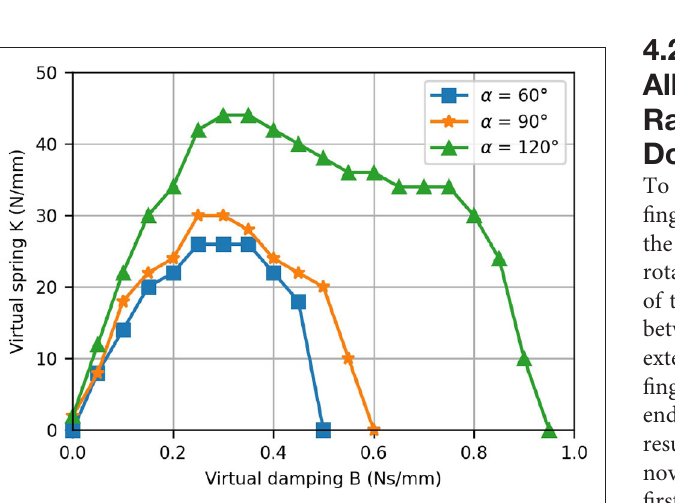
FIGURE 14 | Results from the virtual wall test. The K-B plot shows the stability regions for the rendering of a virtual wall located at different